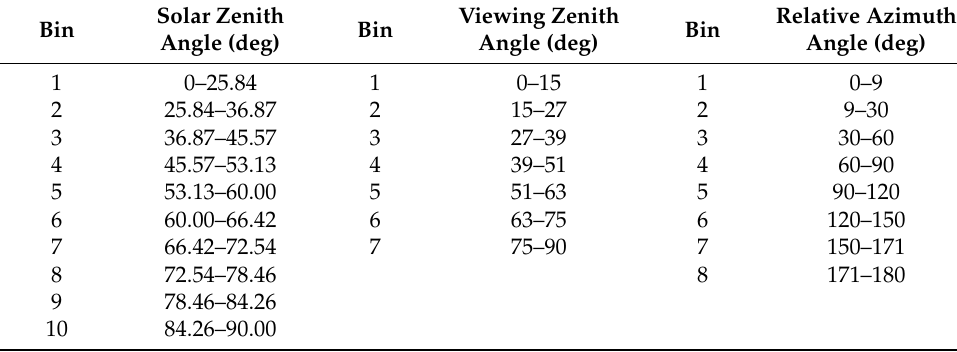
Table 2. Angular bin definitions for ERBE